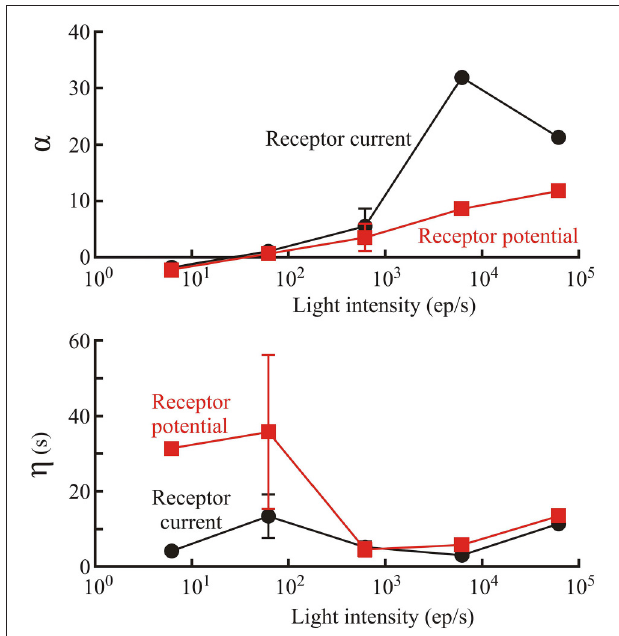
FIGURE 3 | Parameters defining the initial gain change of the phototransduction model (first box of Figure 1). Amplitude, α ; and time constant, η ; of gain change are shown as functions of light level, estimated from photon counts, in Periplaneta photoreceptors. Numbers of experiments contributing to each data value were: 1, 6, 5, 2, and 1 for increasing light levels. Mean values of multiple experiments are shown, and standard deviations are shown for experiments with five and six estimates. Note, that α is dimensionless because the conversion to current or potential was considered to occur in the final nonlinear stage of the model.